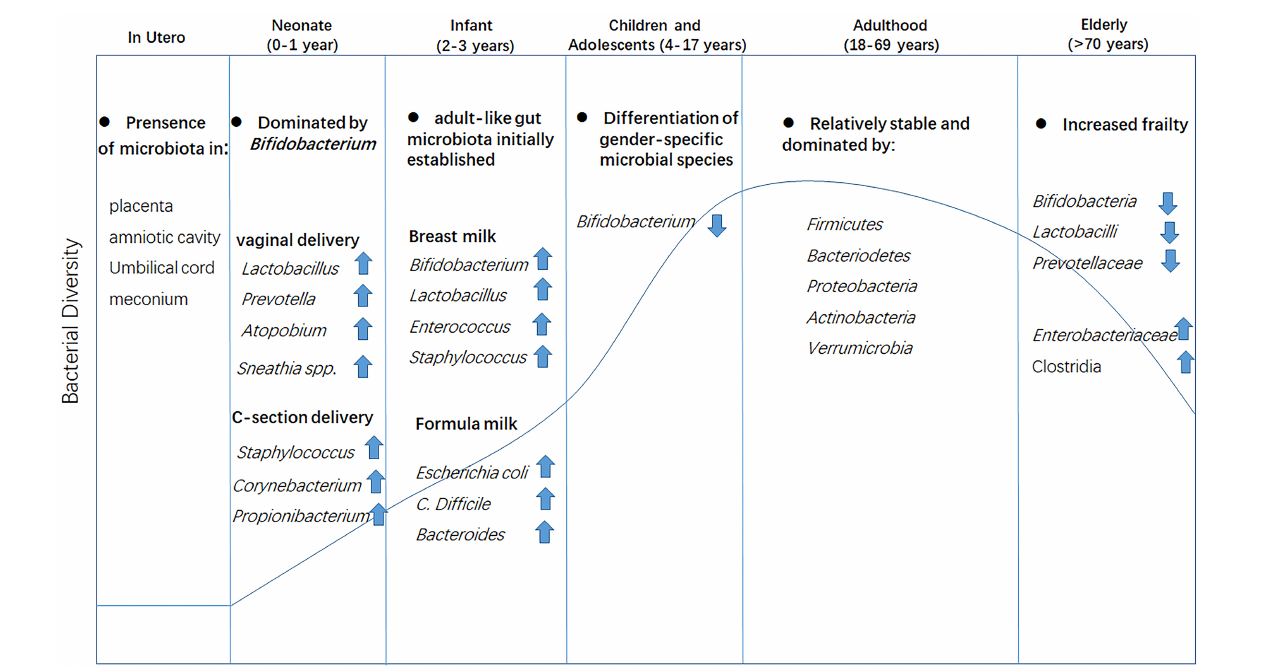
FIGURE 1 | Changes in gut microbiota composition at different life stages. Microbiota colonization may begin in the uterus as evidenced by the presence of bacteria in the placenta, amniotic cavity, umbilical cord, and meconium. The mode of delivery at birth has a direct effect on the bacterial community. The gut microbiota is initially established at approximately 3 years of age and matures at the onset of adulthood with the establishment of dietary habits, leading to a more diverse and stable gut microbial community. In old age, the gut microbiota is drastically altered and diversity is greatly